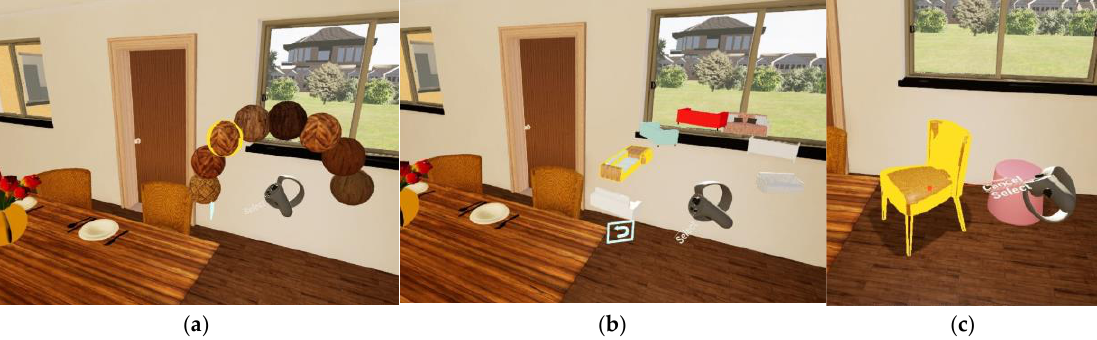
Figure 17. Different interactions are shown above. The controller is surrounded by ( a ) surface materials or ( b ) furniture objects. ( c ) Selection and manipulation tool uses a raycast to select and to place the object at the intersection point with the floor. The rotation of the controller rotates the chair by a factor of two.